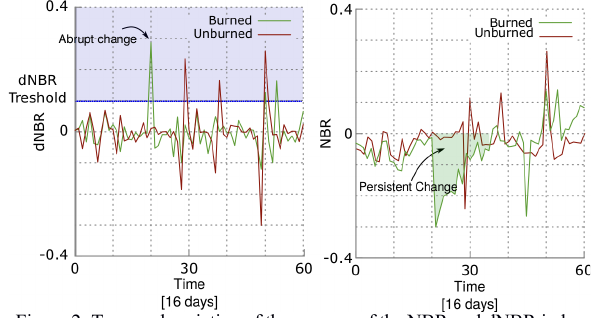
Figure 2: Temporal variation of the average of the NBR and dNBR index on a burned area indicating the abrupt change in the dNBR index and persistent change the NBR index.